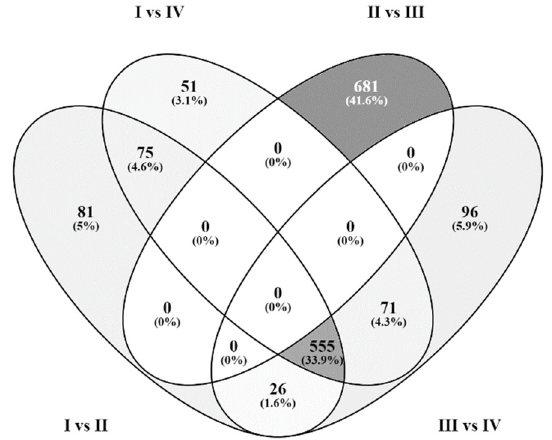
Figure 1. The Venn diagram showing the numbers of common DEGs in four comparisons when upregulated in: group I vs. group IV (5-AZA-dc versus TSA), I vs. II (5-AZA-dc versus 5-AZA- dc+TSA), II vs. III (5-AZA-dc+TSA versus control group) and III vs. IV (control group versus TSA).